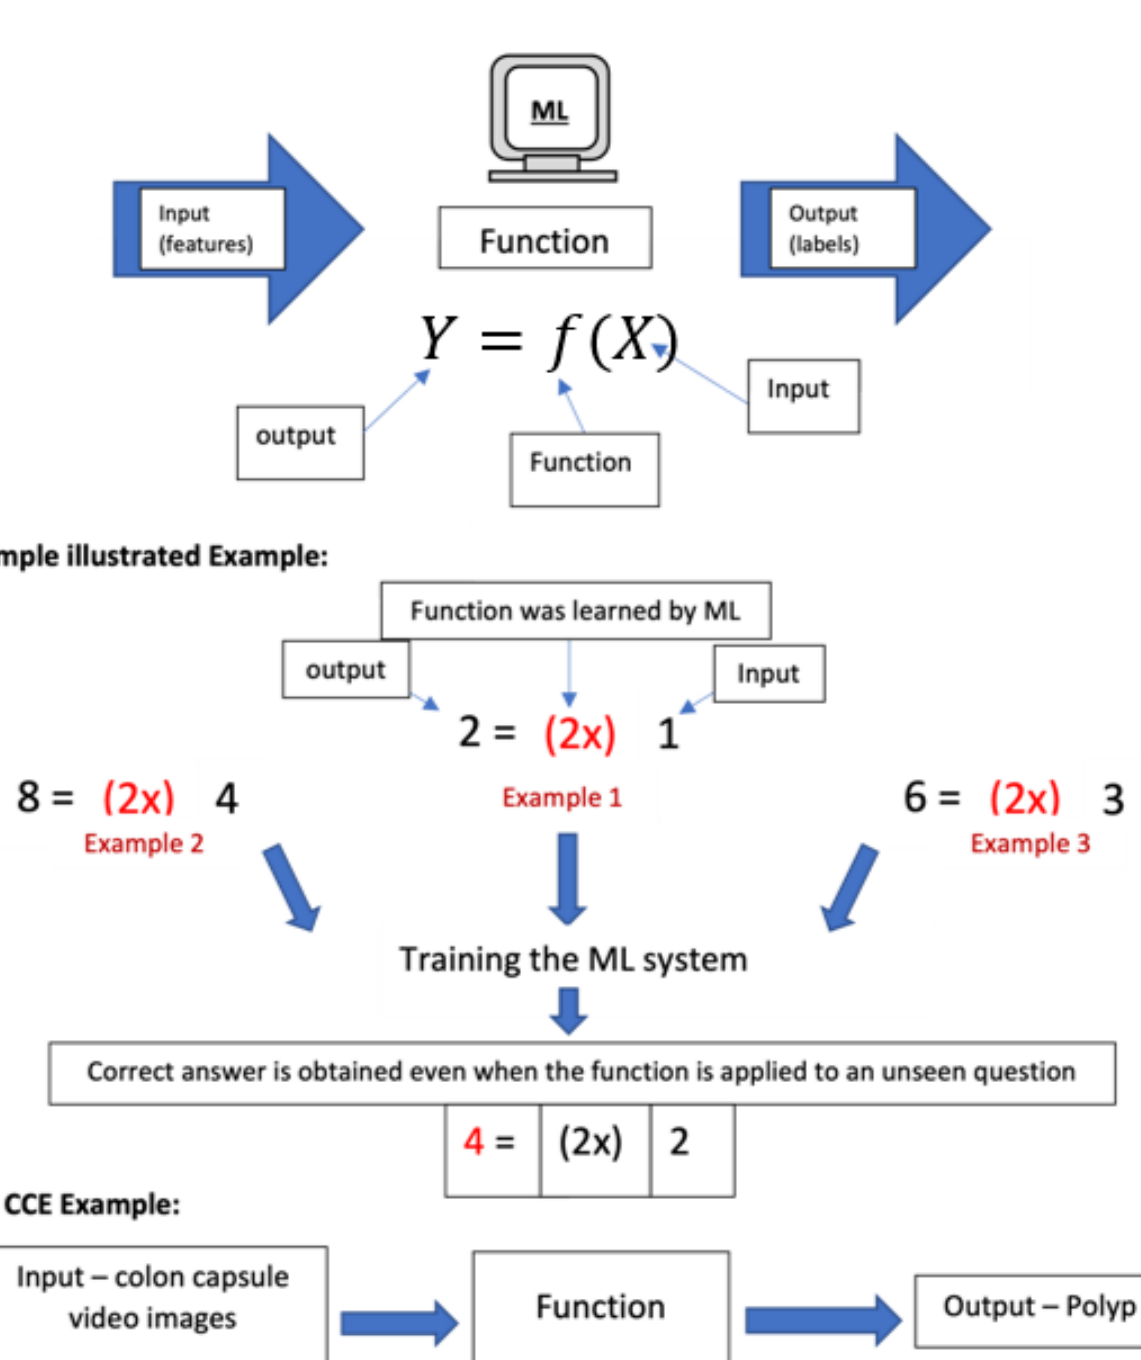
Figure 1. This shows the process of transforming the input into the output by using a function that programmers in computer science create. On the other hand, the machine learning system can learn and develop the function by studying the existing input–output pairs to build a perfect function without relying on the programmer. Examples are included to demonstrate the basic concept of machine learning by using a simple mathematical function.